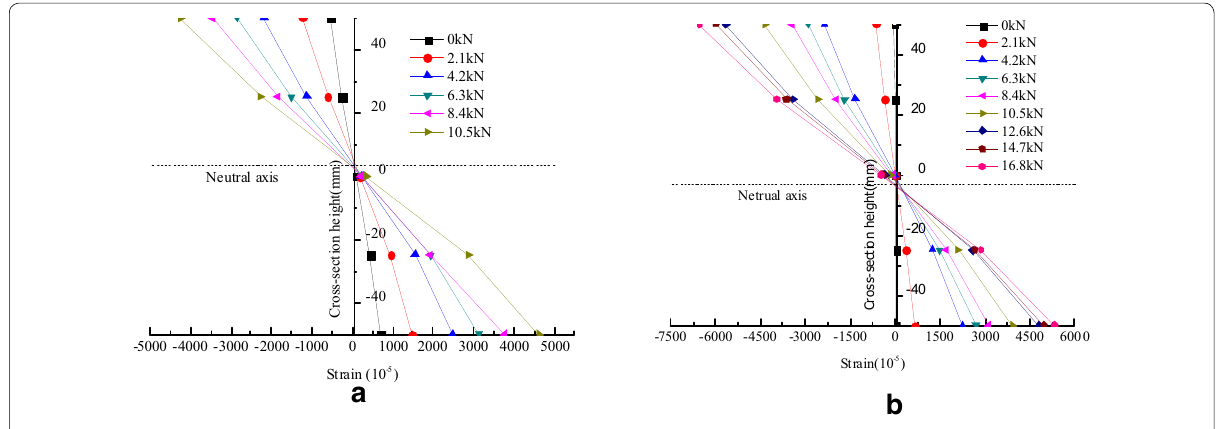
Fig. 8 Curves of strain versus cross-section height a for control beam; b for JGL(B50-1900)